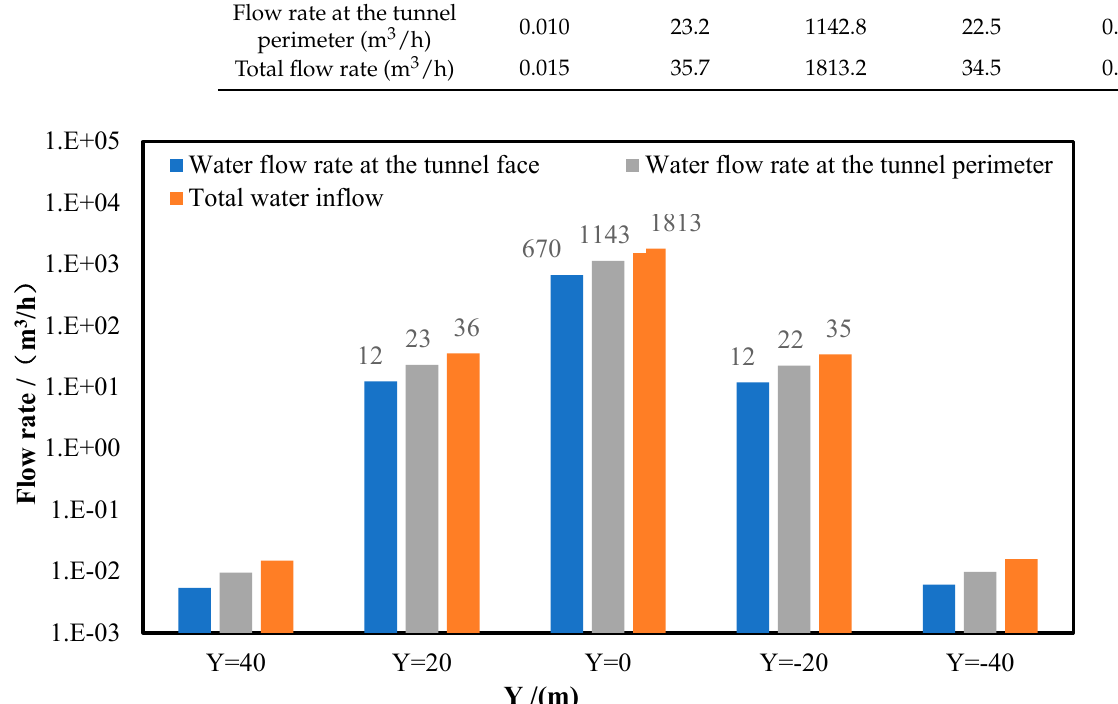
Figure 14. Bar chart of water inflow rates with different relative locations of the fault intersection (Y).